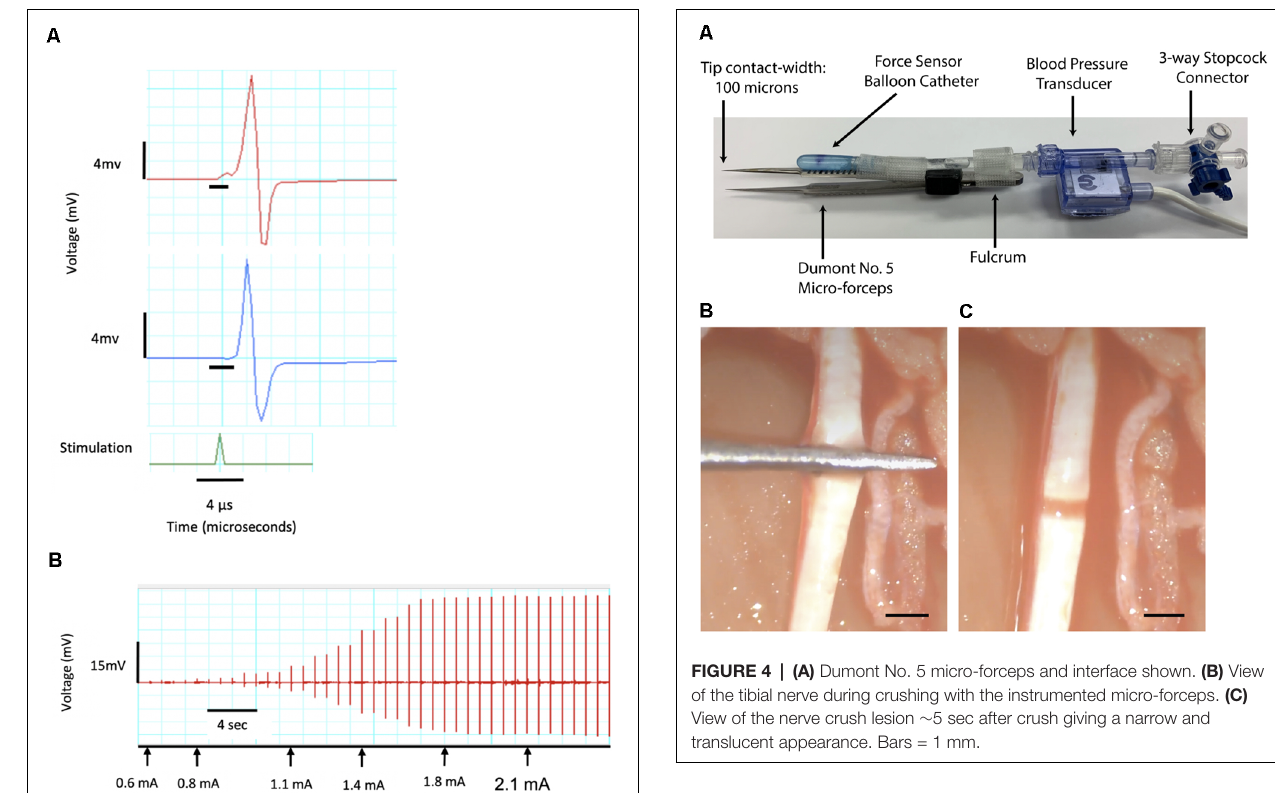
SPSS (IBM SPSS Statistics for macOS, Version 24.0.